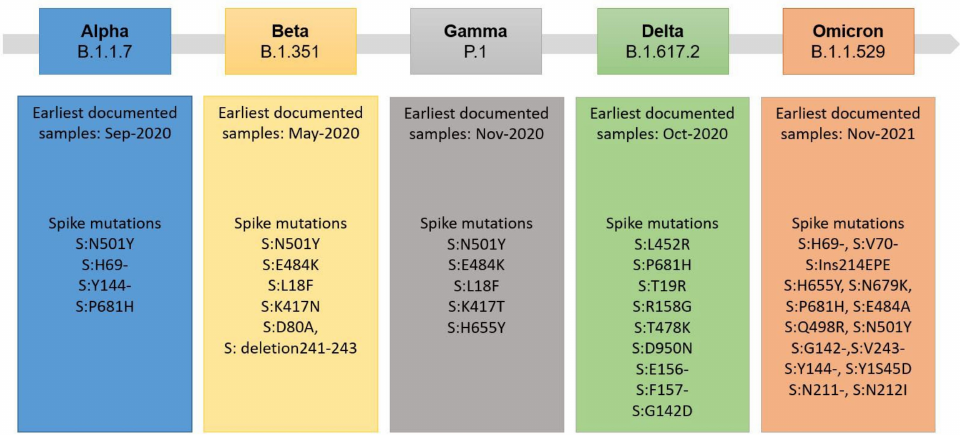
Figure 2. Overview of SARS-CoV-2 variants and notable Spike mutations, which were declared variants of concern (VOC) by the WHO